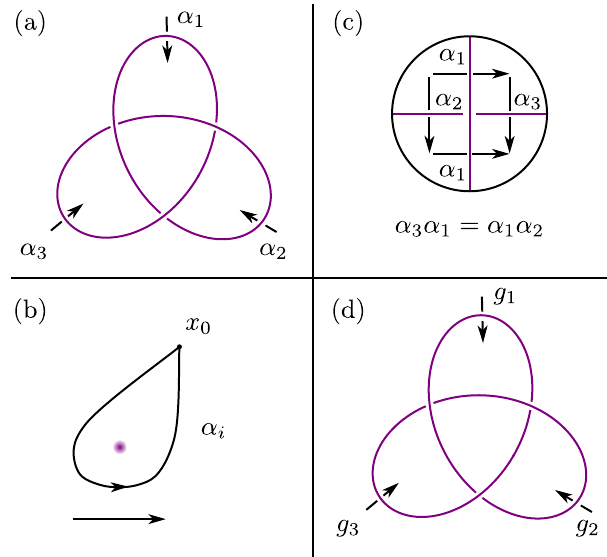
Fig. 1 Wirtinger presentation of the fundamental group of the link complement and colored link diagrams. a , b Link complement R 3 n L (area outside the purple line which denotes L ) and loops denoted by the arrows. After fi xing a basepoint x 0 2 R 3 n L above the plane of the picture ( a ), each